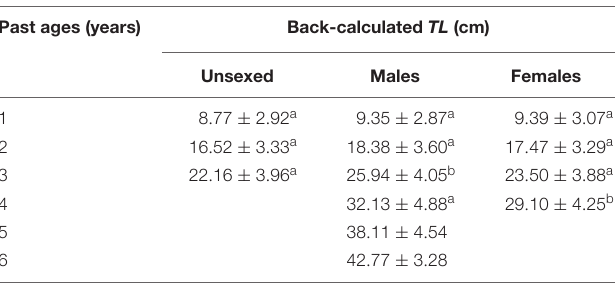
TABLE 2 | Back-calculated total length ( TL , mean ± standard deviation) for past ages of C. trigloides from the southwestern Atlantic Ocean. Past ages